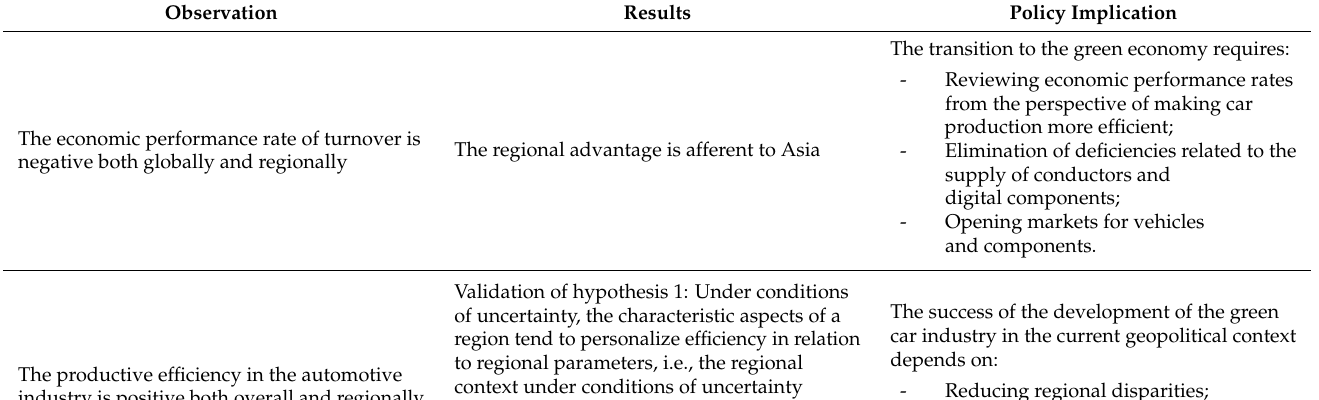
Table 5. Results and policy